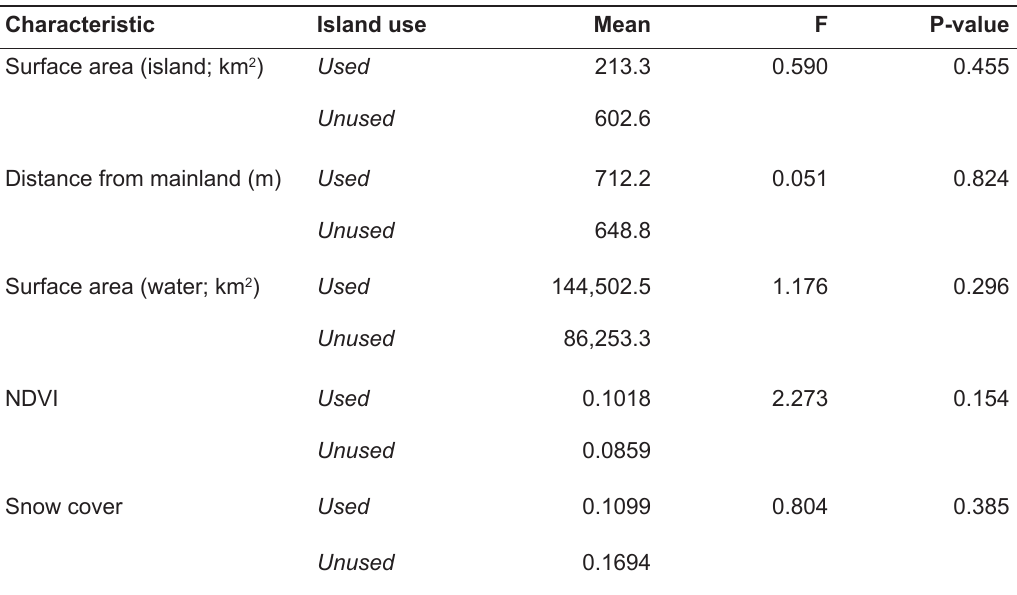
Table 3. Summary statistics of island characteristics. F and the P-value were determined by a one-way ANOVA. Characteristic Island